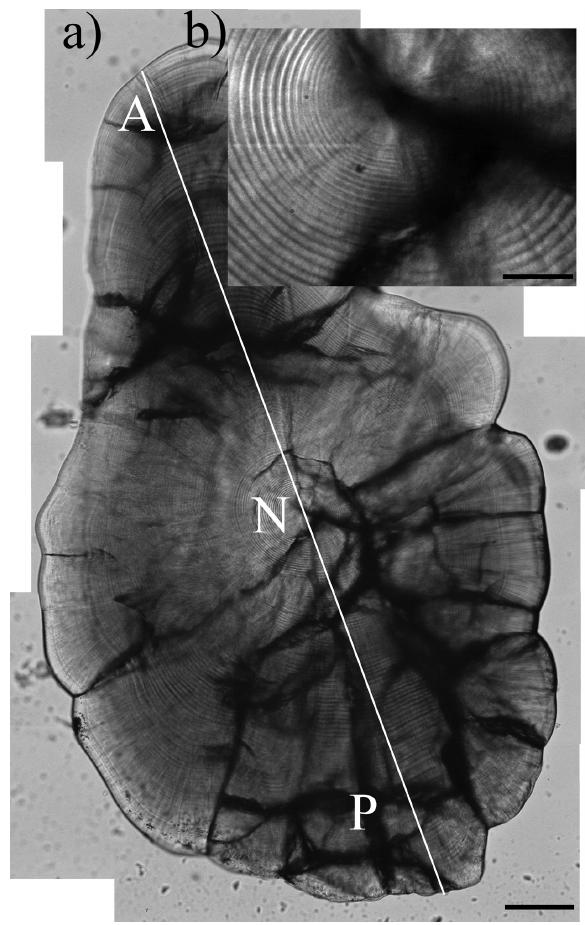
Fig. 1. – Composite micrograph of the otolith of a juvenile sardine, assembled from 26 micrographs of parts of the otolith (scale bar=100 μm) (a) and micrograph of the central area of the otolith. Amplifica- tion, 200× (scale bar=50 μm) (b). A, anterior edge; P, posterior edge; N, nucleus. Line indicates otolith diameter. Amplification,